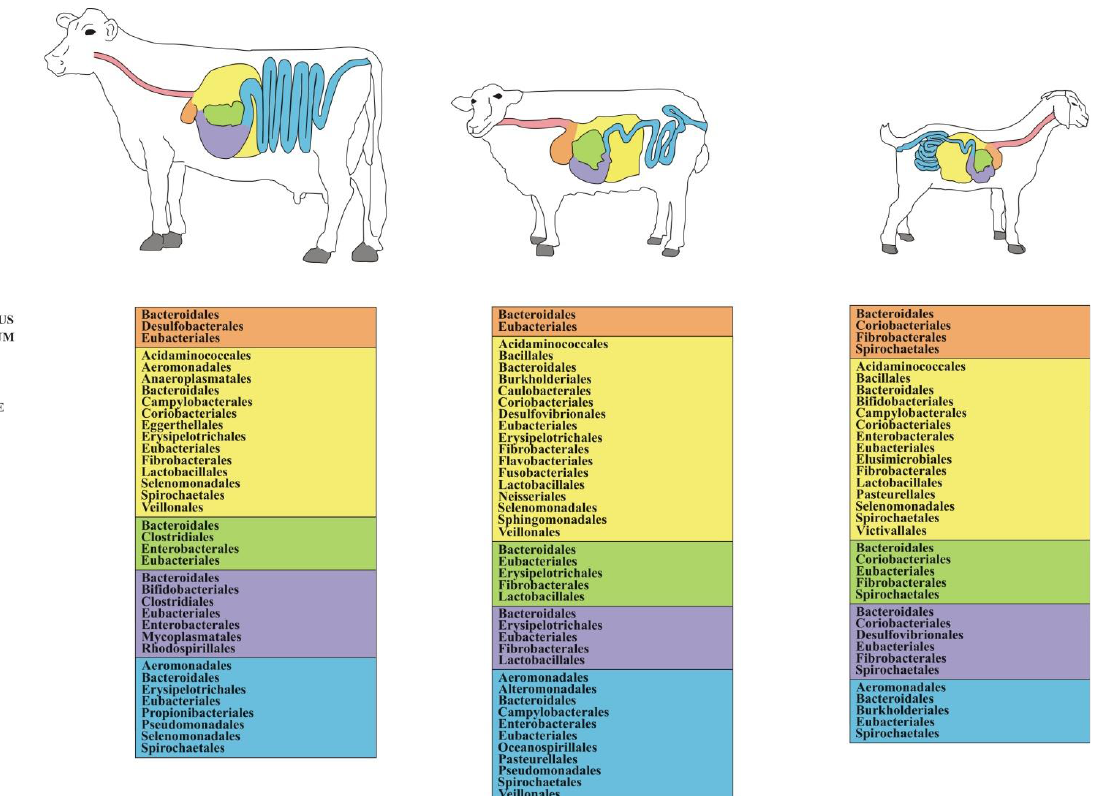
Figure 1. List of the most abundant bacterial orders found across the GITs of different ruminant livestock species (see Table S1 for further details). For the sake of clarity, the intestine designation may refer to both small and large intestines.